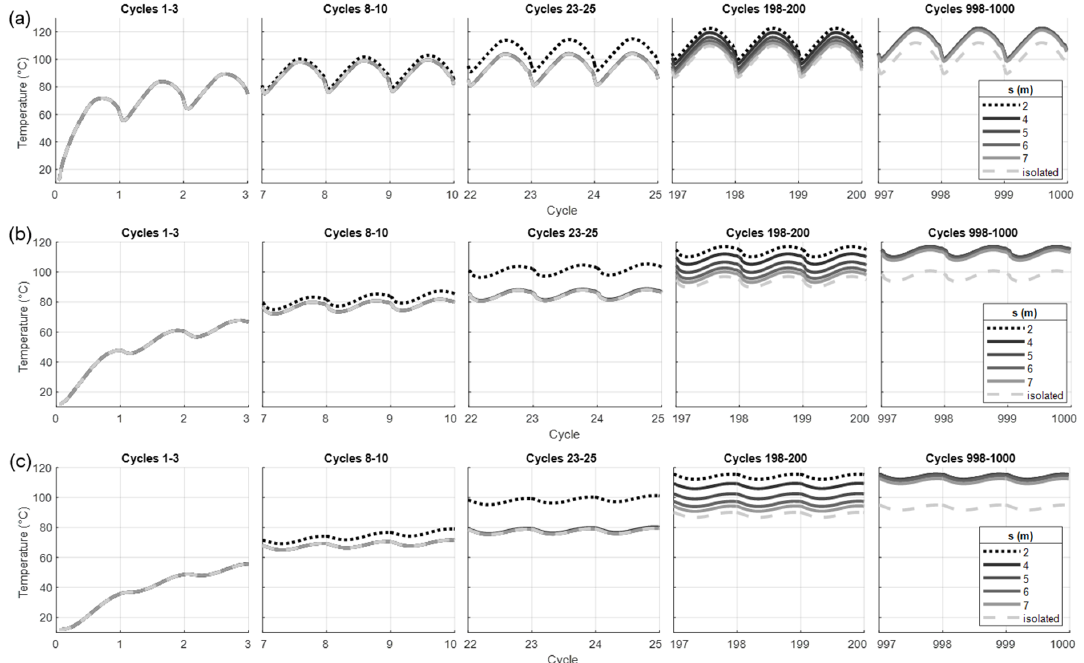
Figure 7. Temperature history within multiple loading cycles (1st–3rd, 8–10th, 23rd–25th, 198–200th, and 998–1000th) for different s at ( a ) the one-third location; ( b ) the two-thirds location; and ( c ) the outer surface.